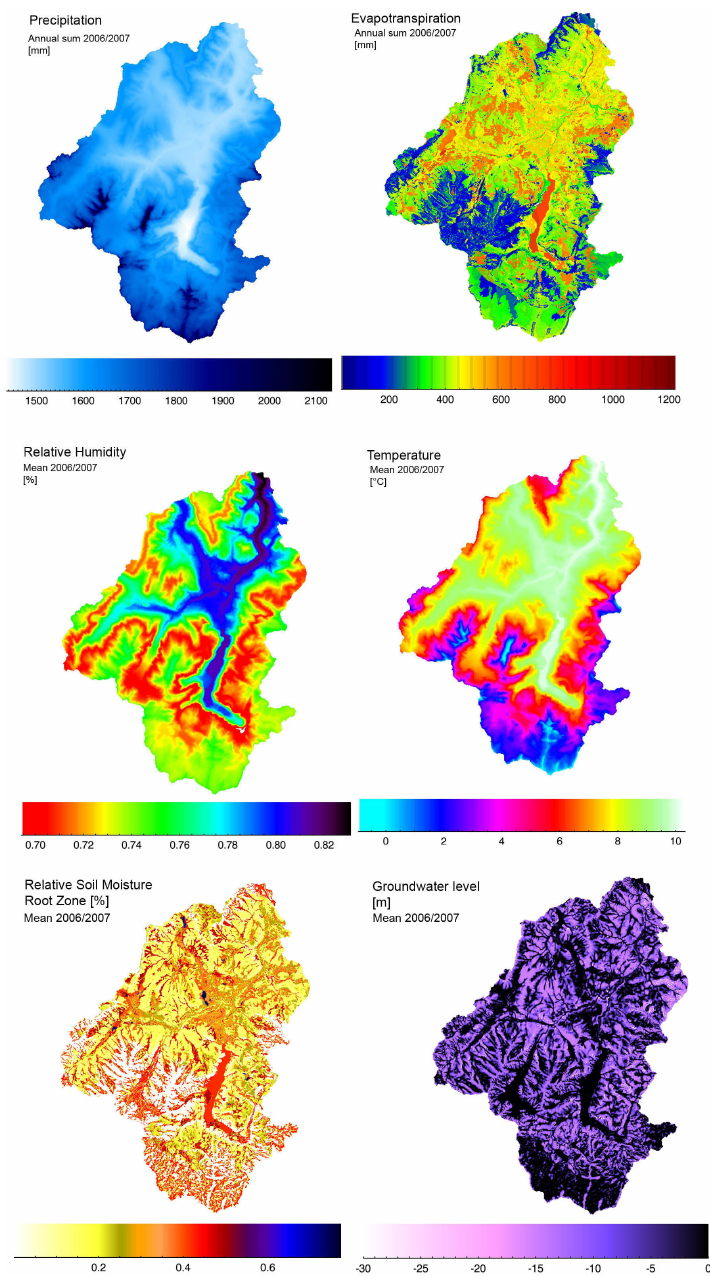
Fig. 14. Spatial water balance results of the hydrological model (before model correction). Precipitation and evapotranspiration, relative humidity, temperature, relative soil moisture and groundwater